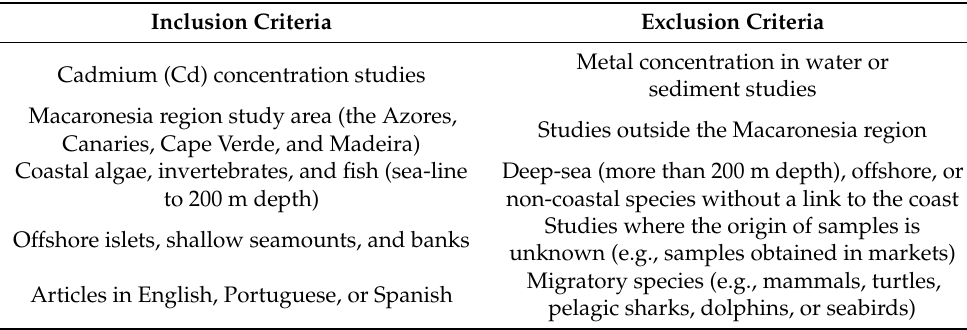
Table 1. Inclusion and exclusion criteria used to select the publications for the final analysis, including Cd studies, location, and coastal species. Inclusion Criteria Exclusion Criteria Metal concentration in water or Cadmium (Cd) concentration studies sediment studies Macaronesia region study area (the Azores, Studies outside the Macaronesia region Canaries, Cape Verde, and Madeira) Coastal algae, invertebrates, and fish (sea-line Deep-sea (more than 200 m depth), offshore, or to 200 m depth) non-coastal species without a link to the coast Studies where the origin of samples